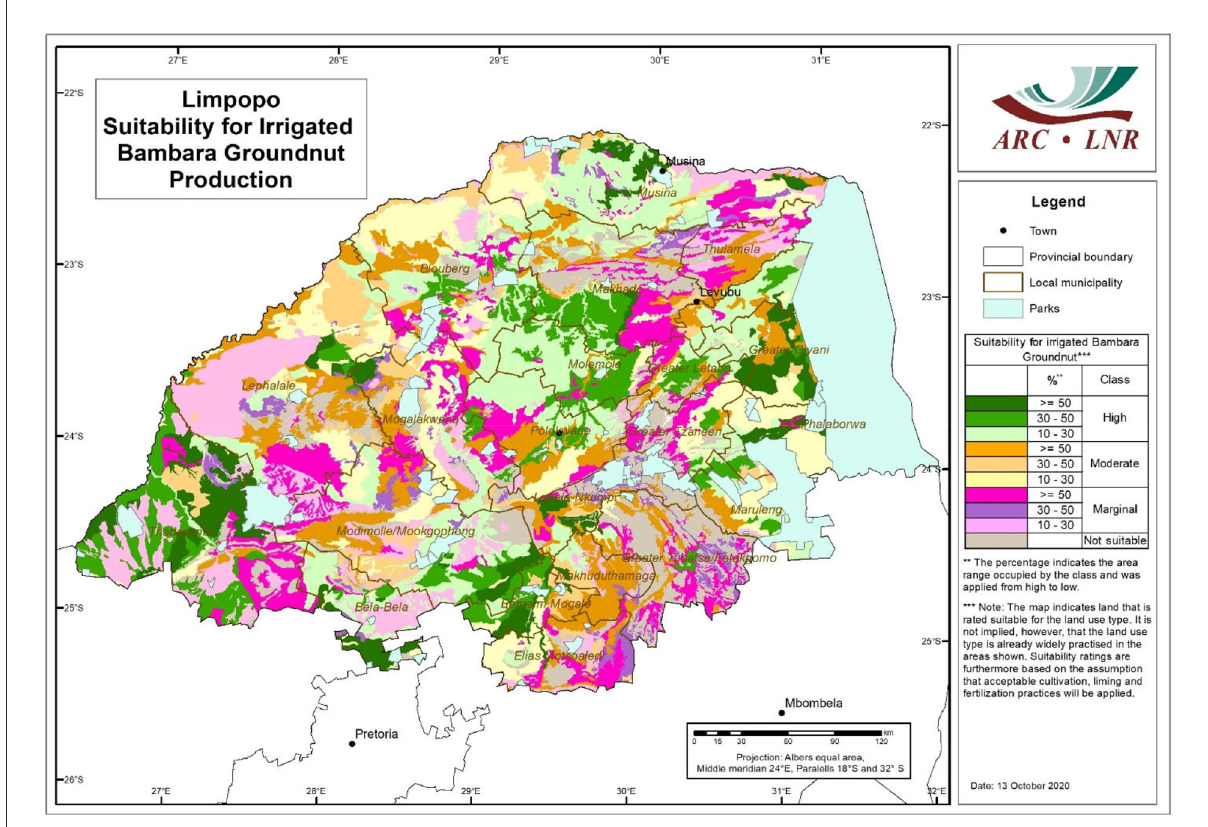
FIGURE4 Suitability for irrigated Bambara groundnut production for Limpopo